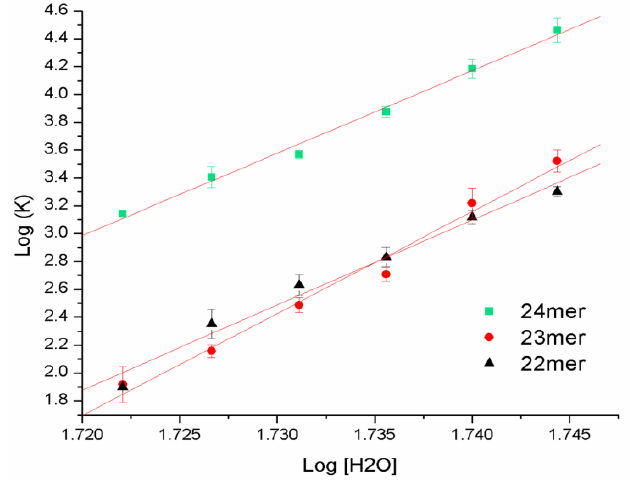
Figure 4. A plot of the change in the binding affinity of water (K concentration of water due to the increasing concentration of glycerol. From the slope of absolute values of the slope are provided in Table 2.